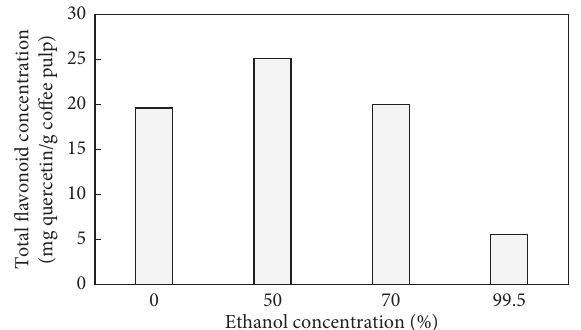
Figure 3: Total flavonoid content of the coffee pulp extracts ob- tained using different ethanol